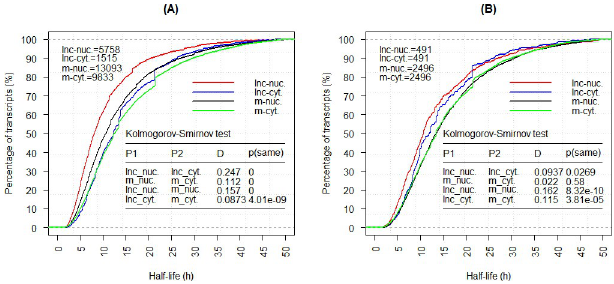
Fig 7. The Half-life cumulative distributions and the related Kolmogorov-Smirnor test for nucleus- and cytoplasm- specific lncRNAs and mRNAs (A), and nucleus and cytoplasm-common lncRNAs and mRNAs (B), in which the lnc- nuc., lnc-cyt., m-nuc., and m-cyt. stands for lncRNAs in the nucleus, lncRNAs in the cytoplasm, mRNAs in the nucleus, and mRNAs in the cytoplasm, respectively.